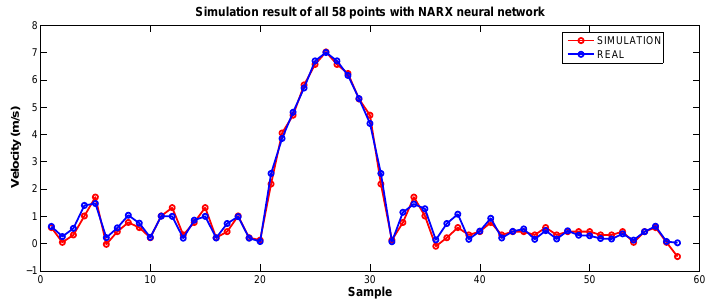
Figure 20. Simulation result of all 58 points with NARX neural network. Source: By